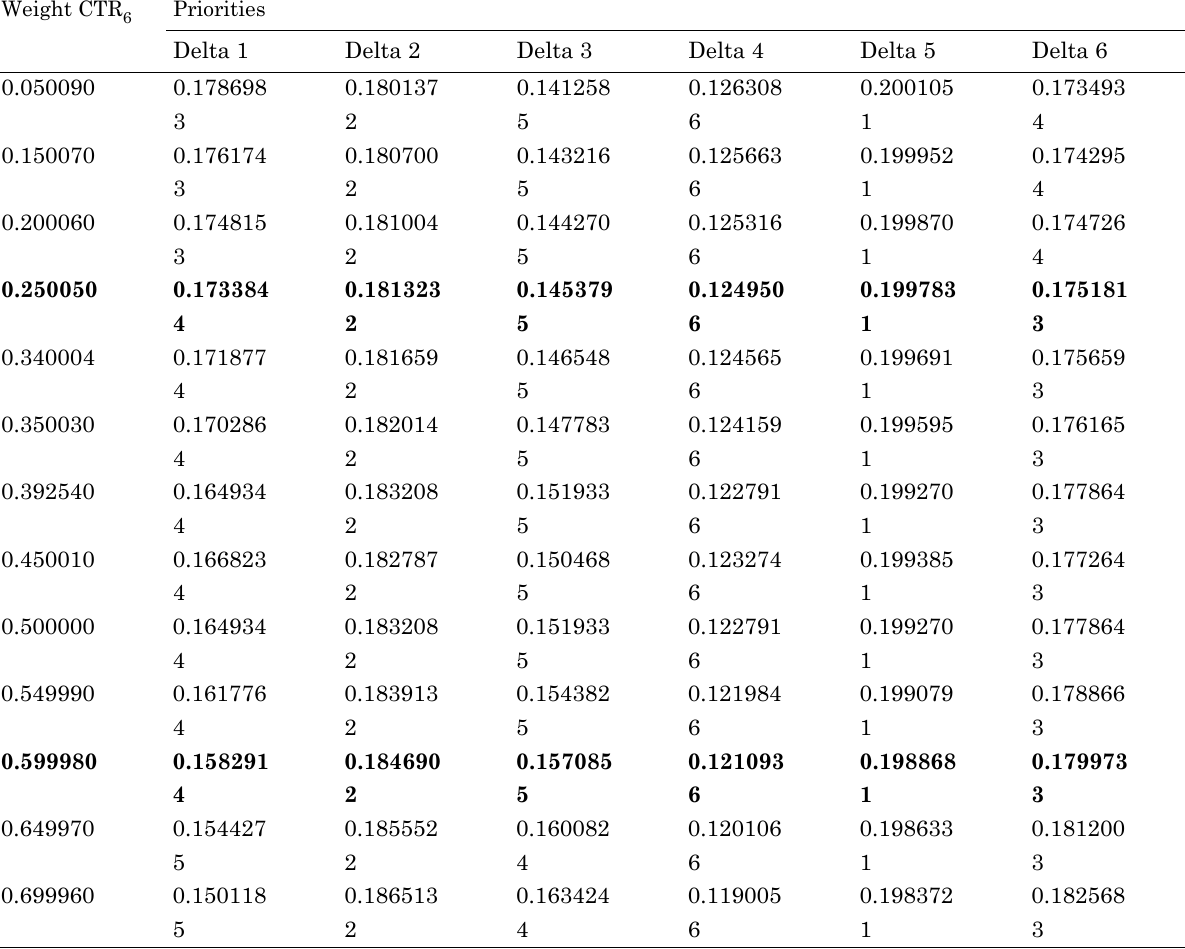
table 9. Sensitivity analysis on ctr